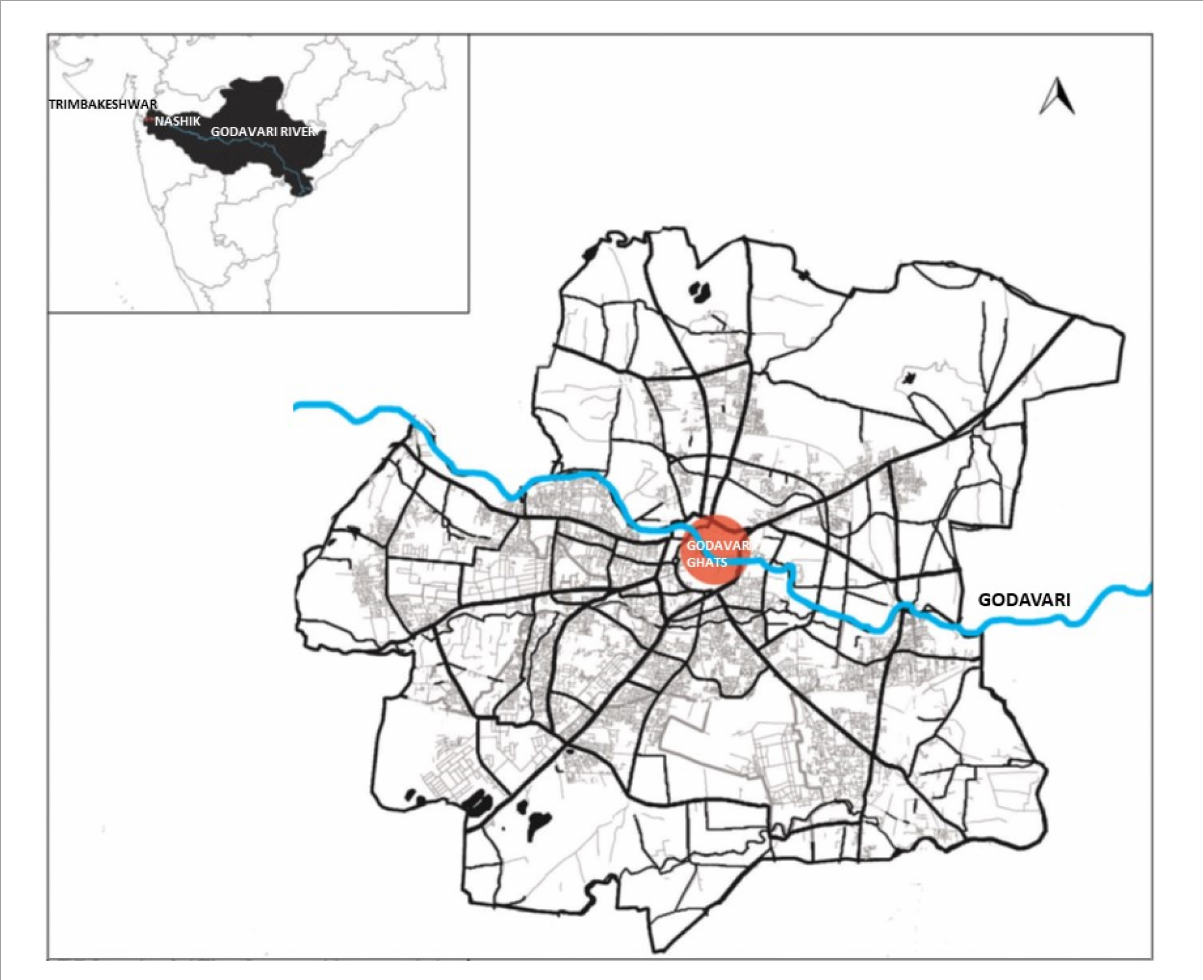
FIGURE9 Map of Nashik highlighting Godavari River and location of Godavari Ghats (Insert: The Godavari Basin) source: Dahake (2018) Map done by Dahake